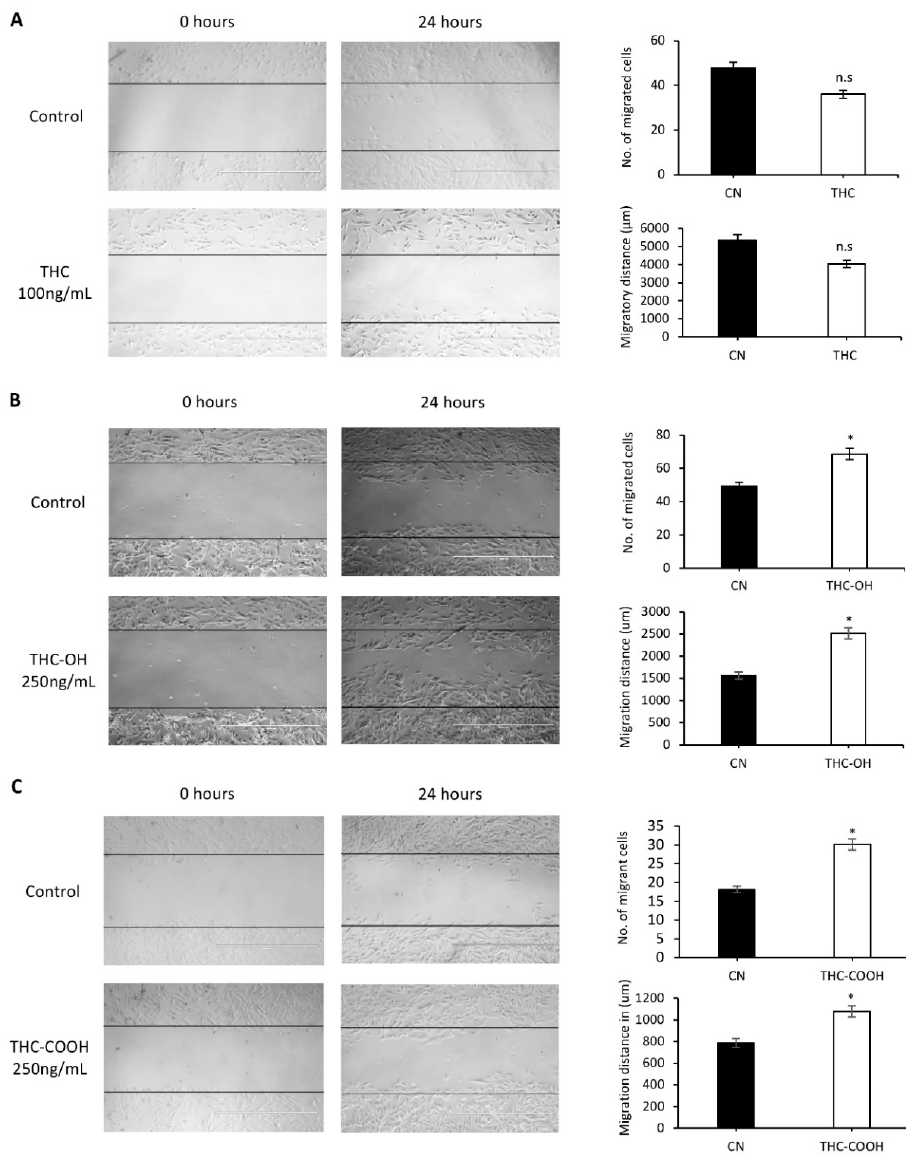
Figure 1. Metabolites of cannabis induce increased wound closure ( A ) H9c2 cardiomyocytes were exposed to 100 ng/mL of THC for 24 h, ( B ) 250 ng/mL of THC-OH for 24 h and ( C ) 250 ng/mL of THC-COOH for 24 h compared with complete growth medium control following scratch wound treatments. The number of migrant cells were quantified by ImageJ analysis software and compared against untreated control cells. The migratory distance of cardiomyocytes in terms of wound healing was determined manually by equivalence of the scale bar and compared with untreated control cells (scale bar was 1000 µ m). Statistical comparison for treated vs. control was performed by a two-tailed Students unpaired t -test (* p < 0.05). n.s. refers to not statistically significant. Results represent the mean of three individual experiments (N =